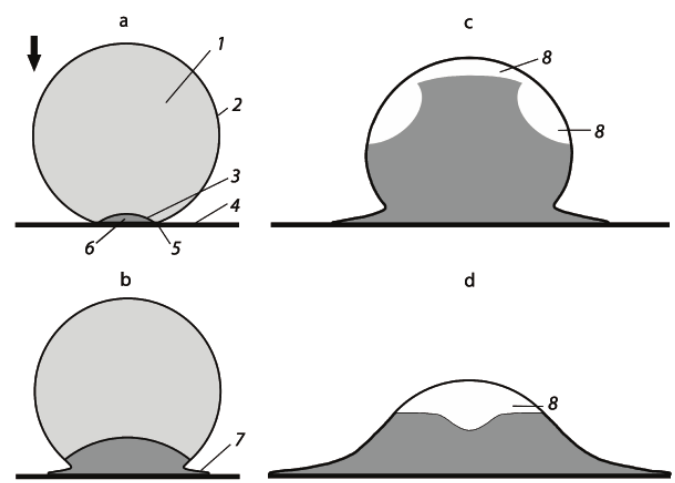
Figure 7. Conceptual illustration of processes occurring when a liquid drop falls onto a surface (encounters an obstacle); adapted from Reference [109]. Panels: ( a ) before spreading; ( b ) jet initiation; ( c ) shockwave approaches the top of the drop, toroidal expansion region is formed; and ( d ) initiation of vast expansion area with cavitation region. Zones: (1) unperturbed liquid, (2) free drop surface, (3) shockwave, (4) obstacle’s surface, (5) contact boundary, (6) compressed liquid area, (7) jet, and (8) cavitation